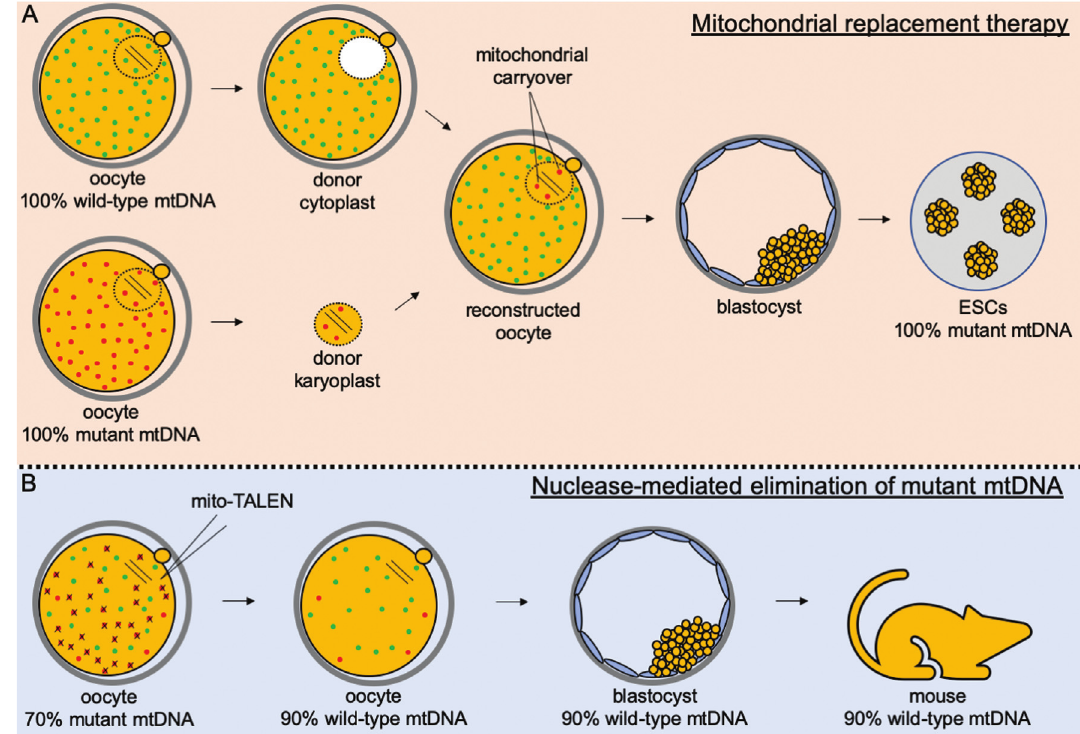
Figure 3 - New technologies for preventing inheritance of mitochondrial diseases. The mitochondrial replacement therapy (MRT; A) proposes the re- placement of a patient’s mitochondria in oocytes by donor mitochondria. Towards that, mature oocytes arrested at the metaphase-II stage are collected from the patient and a donor. While the patient’s oocytes are supposed to contain mutant (red) mitochondrial DNA (mtDNA), donor oocytes should con- tain only wild-type (green) mtDNA. Next, the spindle is removed from the patient’s oocyte (donor karyoplast) to be injected into the donor oocyte from which the spindle was previously removed (donor cytoplast). Fertilization of the reconstructed oocyte should lead to a blastocyst, which can be used for embryonic stem cell (ESC) derivation. Although MRT allows transplantation of karyoplast with minimal carryover (~1%) of mutant mtDNA, recent data have provided evidence of a reversal in ESCs back to 100% mutant mtDNA (Hyslop et al. , 2016; Kang et al. , 2016). An alternative strategy to MRT is the nuclease-mediated elimination of mutant mtDNA (B), which relies on the use of mitochondrial-targeted restriction endonucleases (mito-TALENs). ThesenucleasesaredesignedtoselectivelycutmutantmtDNA,butnotwild-typemolecules.However,~10%oftargetedmoleculeswereshowntobeleft uncut in newborns after use of mito-TALENs (Reddy et al. ,